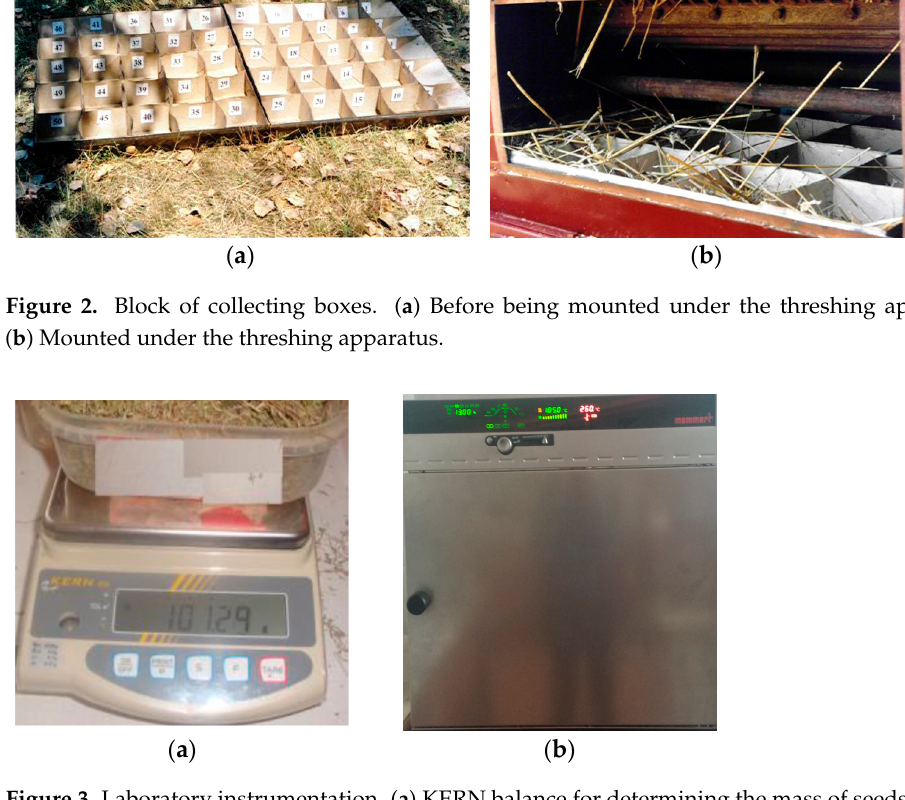
Figure 3. Laboratory instrumentation. ( a ) KERN balance for determining the mass of seeds/straws. ( b ) Memmert oven for determining seed/straw moisture (Author(cid:31)s own pictures). ( b ) Memmert oven for determining seed/straw moisture (Author’s own Mathcad software was used to process the experimental data and plot the graphs.